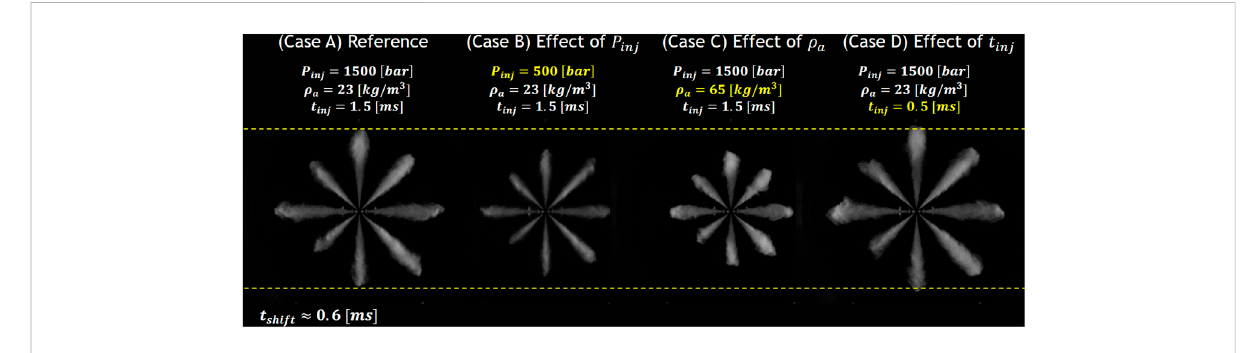
FIGURE 5 Visualization of the multi-hole spray penetration length observed from the front view in various operating